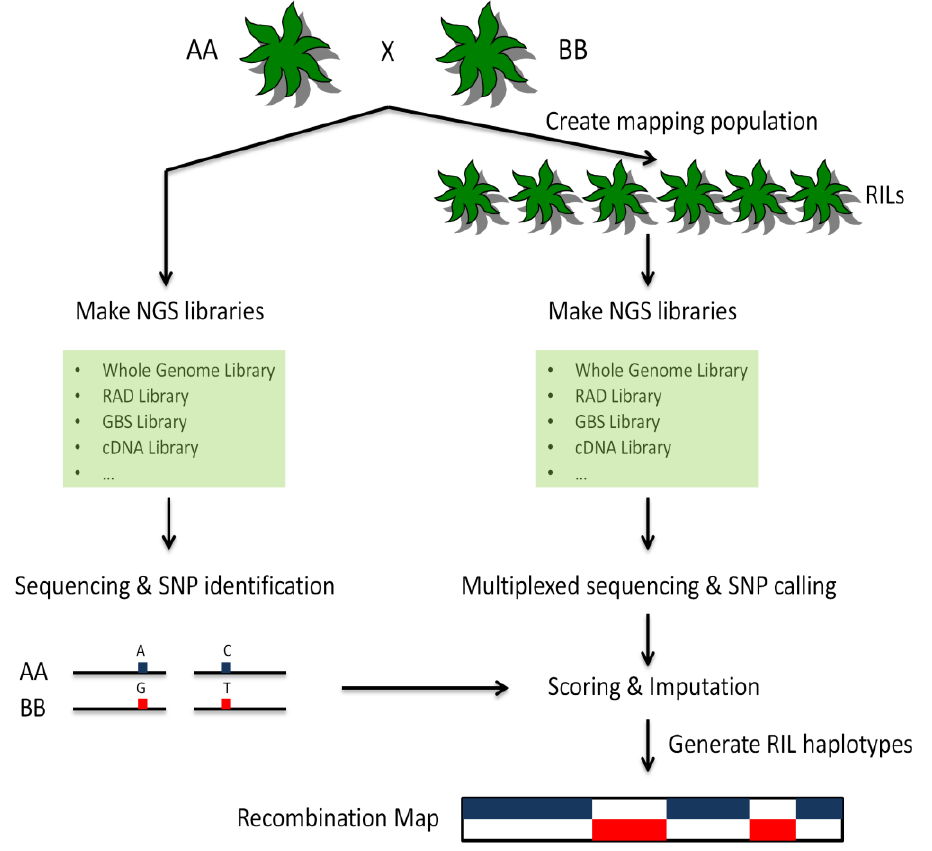
Figure 1. Schematic diagram of a representative GBS procedure. Two parents (AA and BB) are selected to create a mapping population. The parents are deeply sequenced using NGS technologies. SNPs and other variations between them are identified. The RILs are prepared using the same library construction strategy as the two parents (see text for details) and sequenced at lower coverage using NGS technologies. The resulting sequences are used to determine allelic diversity for each individual. Genotypes are assigned based on parental information. Haplotypes and recombination maps are created for each RIL. Blocks of haplotypes can be used directly as markers for mapping